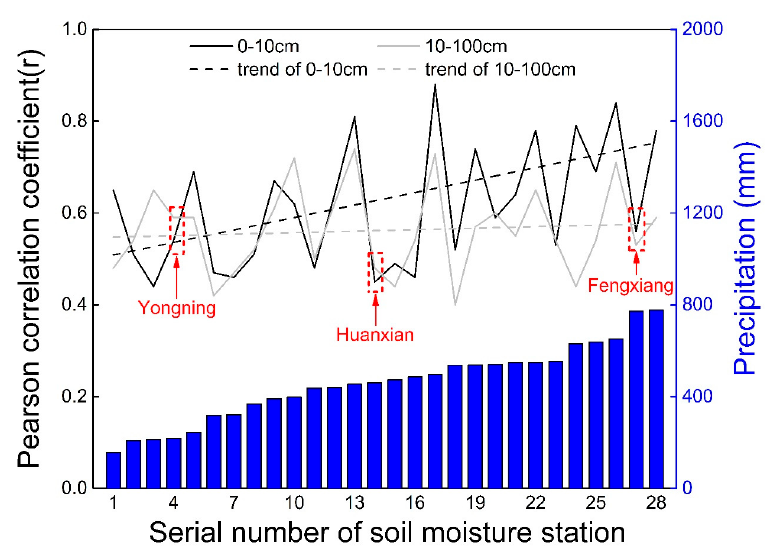
Figure 3. The correlation coefficient between simulated and observed soil moisture anomalies for soil depths of 0–10 cm and 10–100 cm.